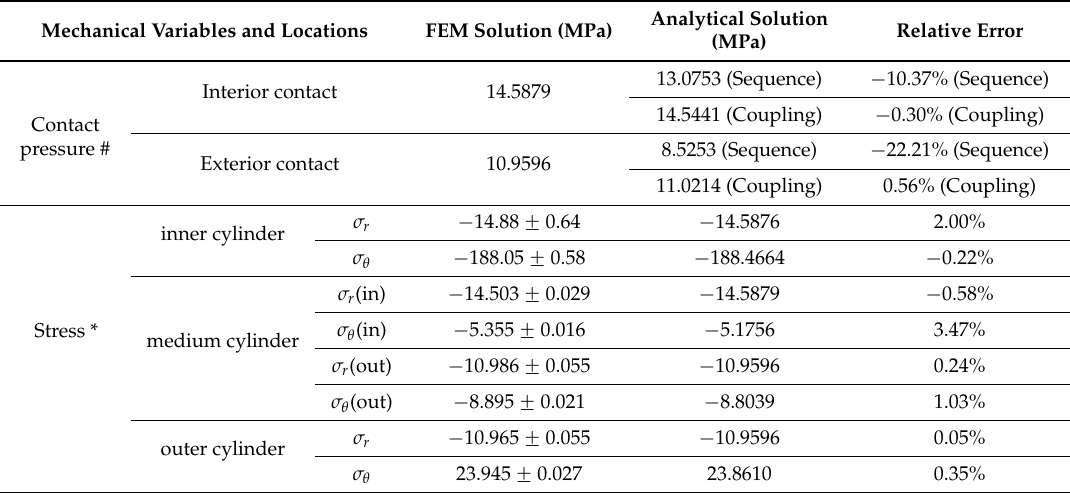
Table 2. Contact pressure and stress analysis for tri-layer thick-walled cylinders by FEM and analytical